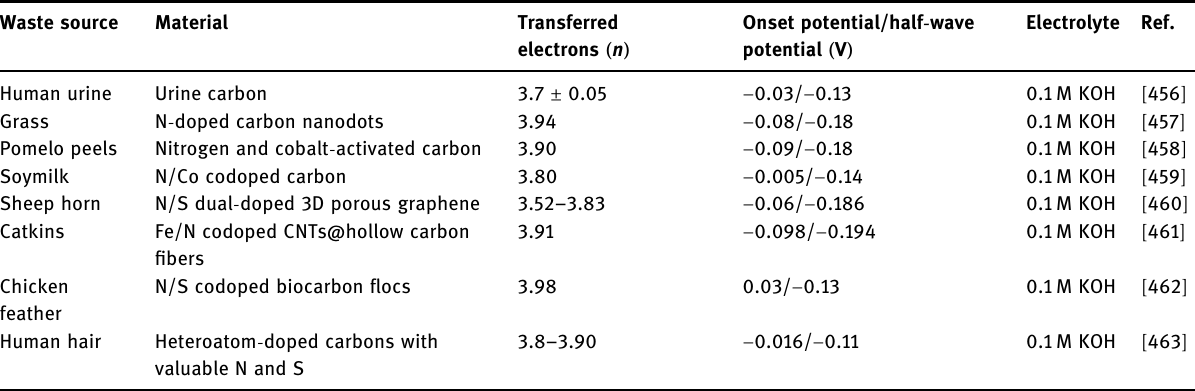
Table 7: Summary of common waste - recycled carbon materials used for fuel cell applications